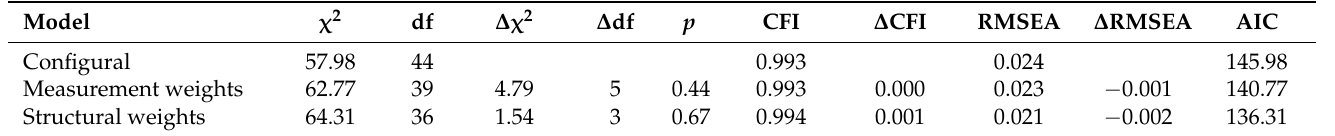
Table 11. KABC-II core subtests: Invariance of the CHC second-order model without Rover across age